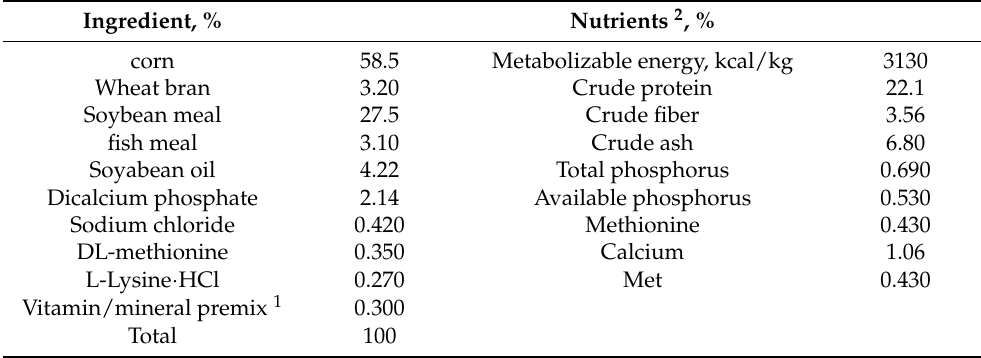
Table 2. Ingredient composition and calculated nutrient content of the basal